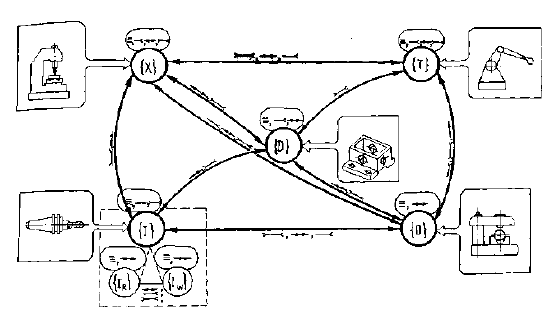
Fig. 2. Graph of relationships of process medium sets of automated